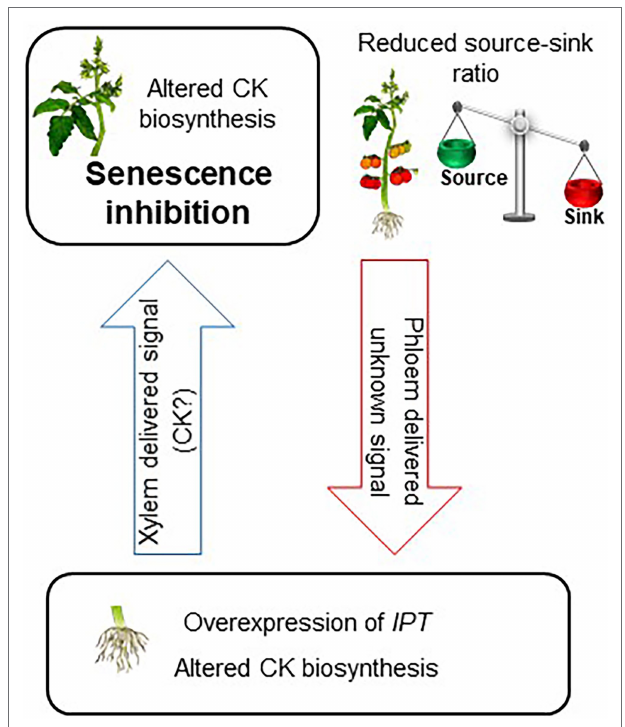
FIGURE 6 | Model for root CK biosynthesis effect on the functioning and aging of source leaves. Reducing source–sink ratio or overexpression of IPT under a root-specific promoter leads to altered CK biosynthesis in the roots. This change in root CK metabolism elicits root-to-shoot translocation of a signaling agent to promote alteration in CK biosynthesis in the leaves. Specific spatial and quantitative accumulation of CK results in delayed senescence of source